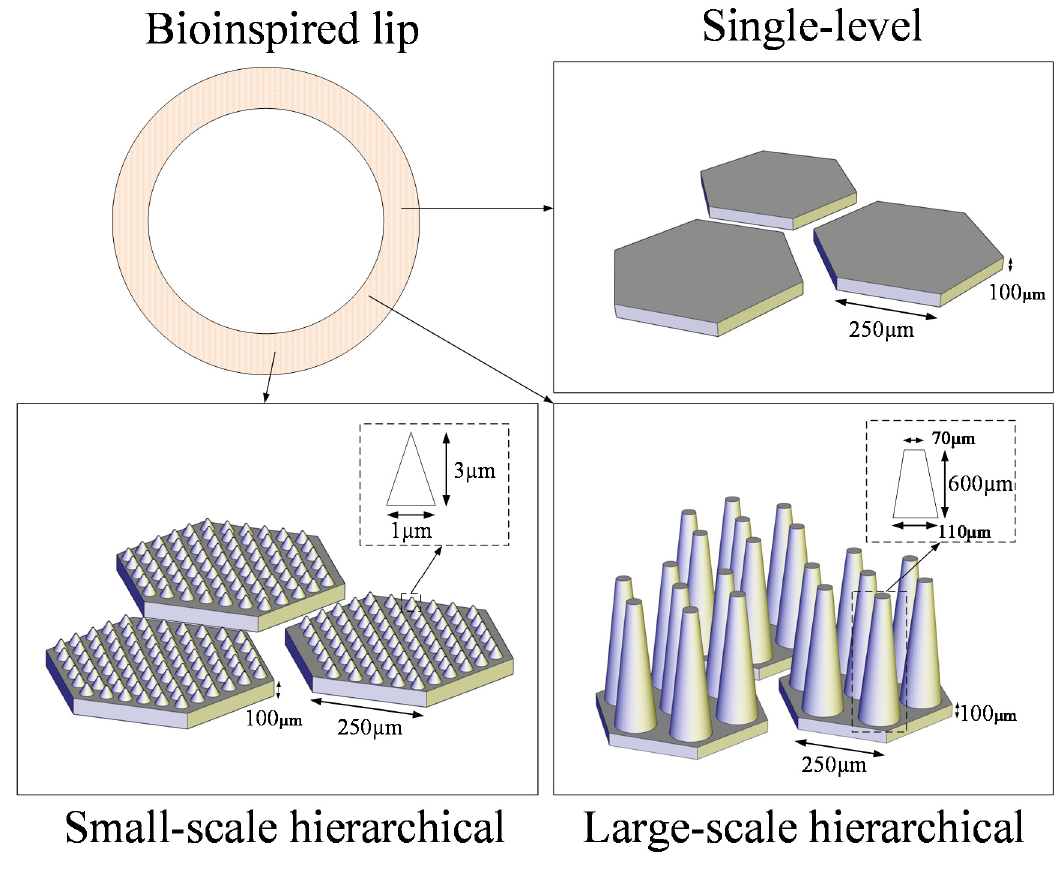
Figure 2. Schematic of the bioinspired microstructure.